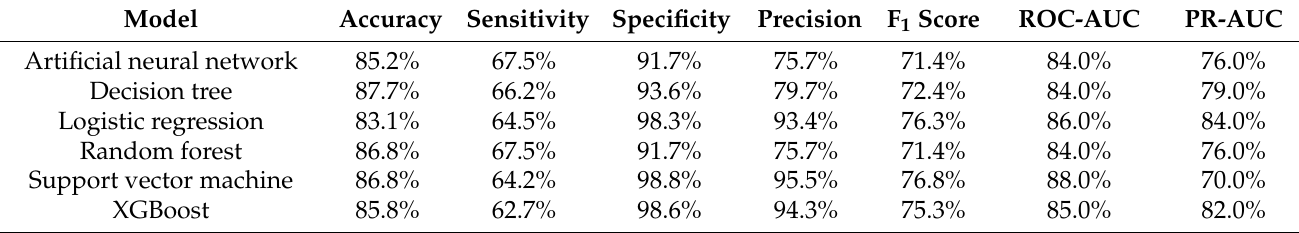
area under the curve.